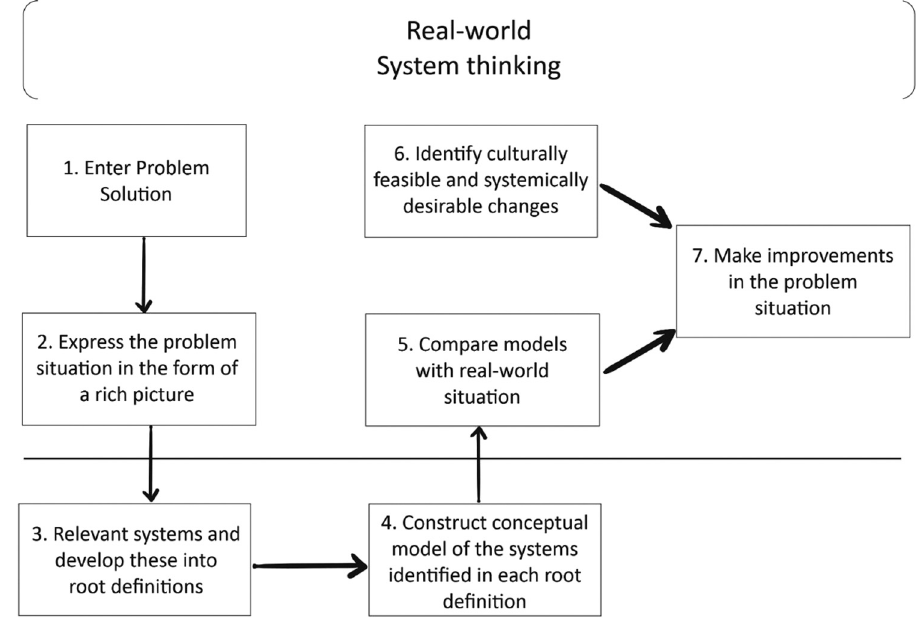
Figure 2: Soft system method is described in the form of a seven - stage model [ 43 ]